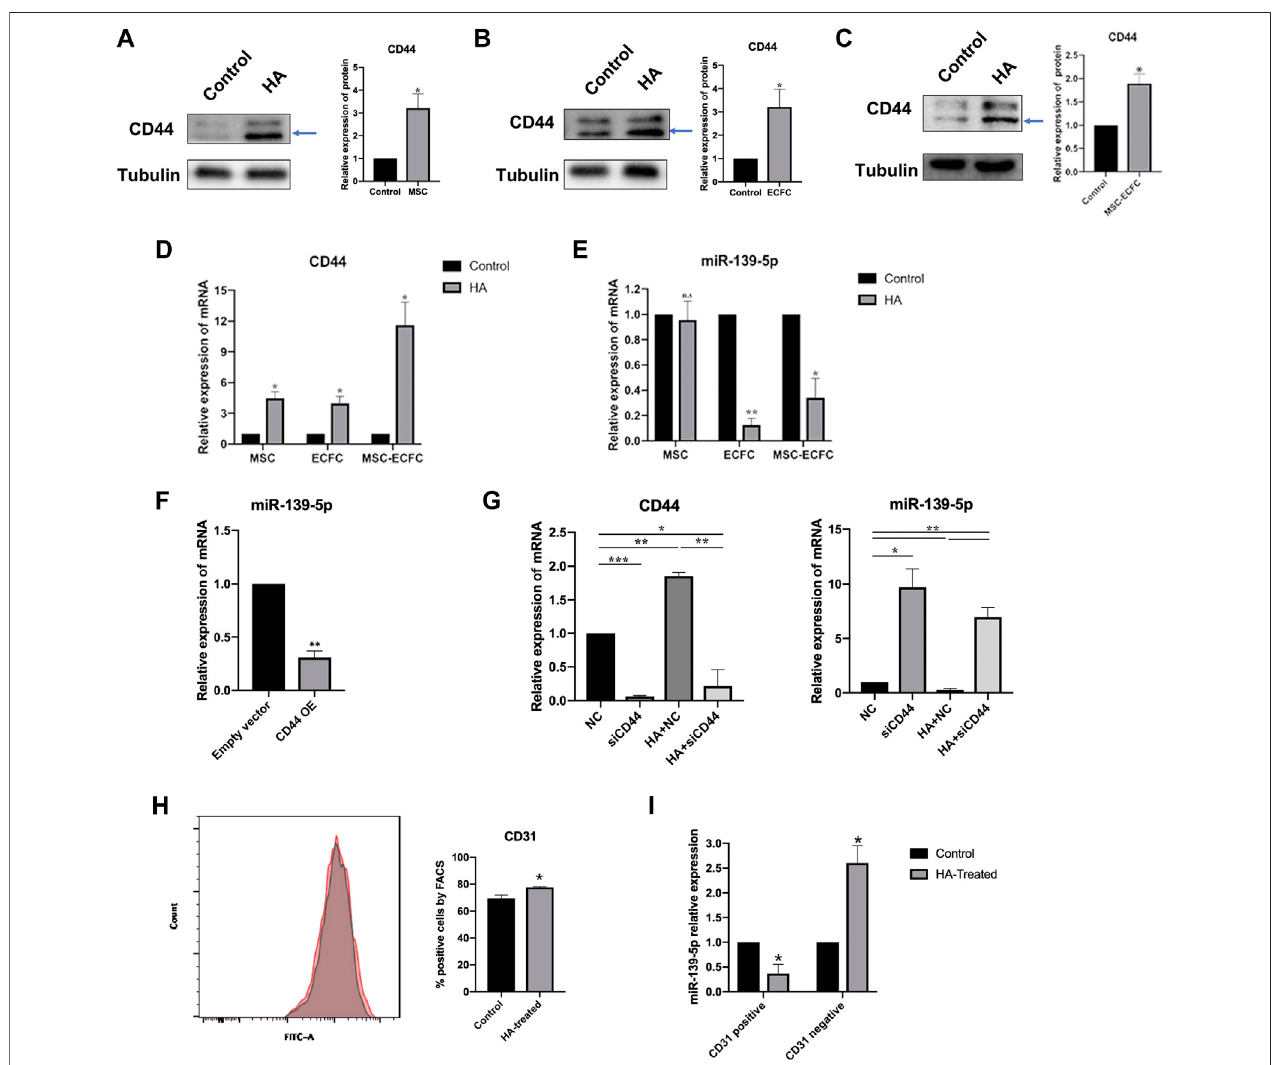
FIGURE 5 | HA inhibits miR-139-5p expression by activating CD44. (A – C) . Western blot assays and qPCR assays (D,E) were performed to test CD44 and miR- 139-5p expression after HA treatment in MSCs, ECFCs and MSCs-ECFCs, respectively. (F) . Relative miR-139-5p expression in ECFCs transfected with CD44 overexpressionplasmid. (G) .qPCRassayswereperformedtotesttheCD44andmiR-139-5pmRNAexpressioninECFCstransfectedwithCD44siRNA,withorwithout administration of HA, respectively. (H) . Flow cytometry of CD31 sorted from MSC-ECFC co-cultured system, with (red) or without (grey) administration of HA, and quanti fi cationof fl owcytometry. (I) .RelativemiR-139-5pexpression inthesortedCD31 + cellsandCD31 − cells,respectively.( n